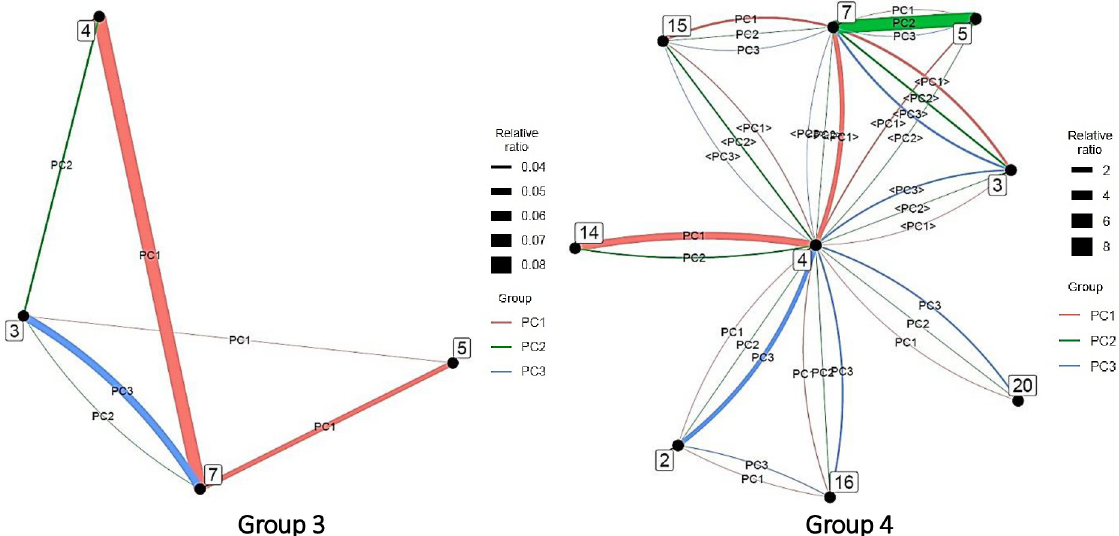
Fig 10. Principal component analysis for each artificial intelligence group. Note . < PC# > has factor loadings below 0.300 but are shown as reference information.